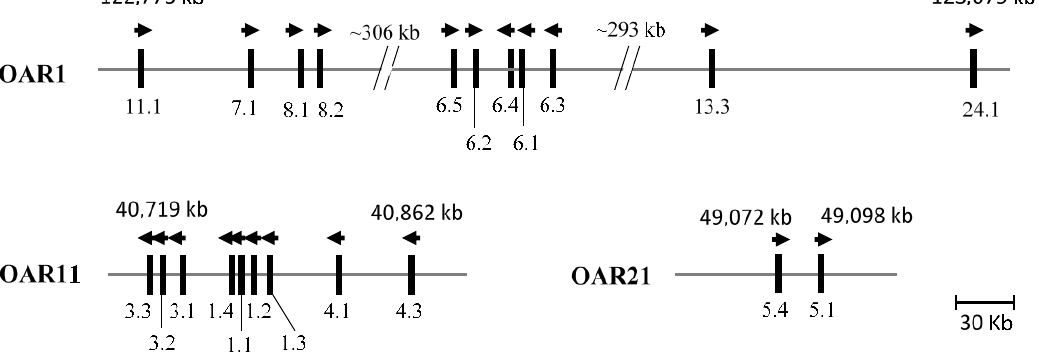
Figure 2. Clustering of the ovine KAP genes in three chromosome regions. The bolded vertical bars represent known KAP genes and the arrows indicate the direction of transcription. The numbers below these bars are the KAP gene names ( i.e. , 11.1 refers to KRTAP11-1 ). The spacing of the genes is only approximate and is based on the Ovine Genome Sequence Assembly v4.0 sequence, where coordinates are given for the boundaries of the clusters, based on the first and last gene identified in the